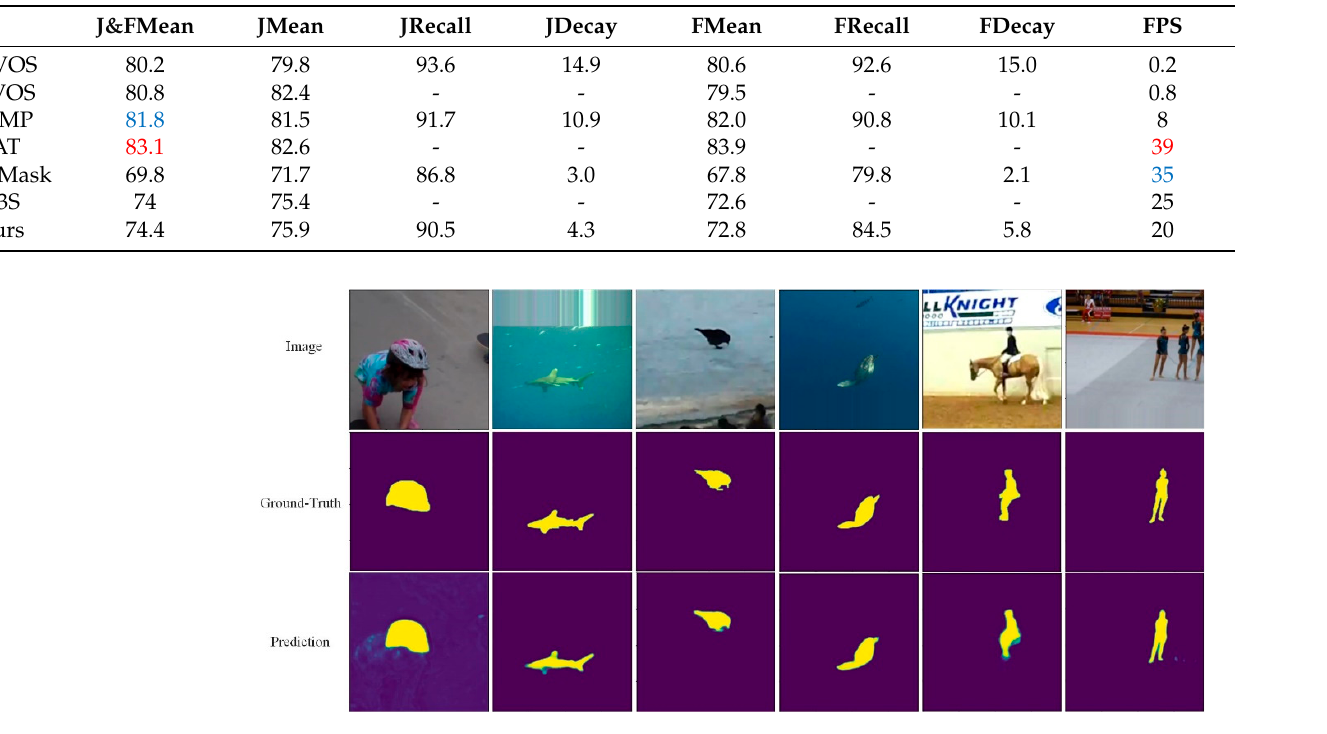
Figure 7. The refinement pathway proposed in this paper optimizes the segmentation accuracy. The first row is the input image, the second row is the label of the input image, and the third row is the segmentation result of the tracker proposed in this paper.